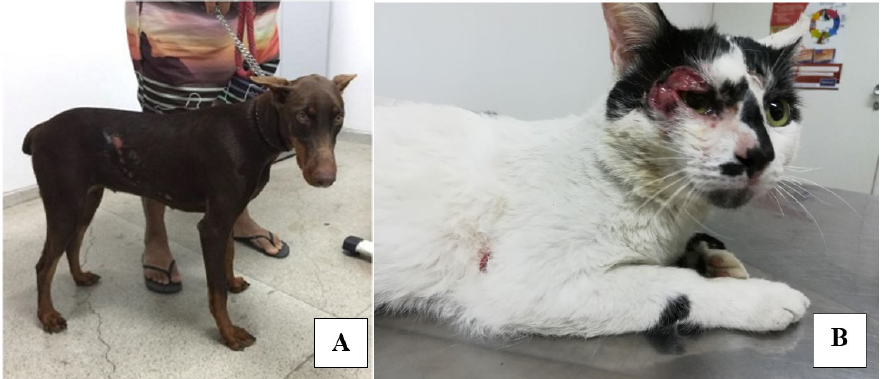
Figure 2. Canine with ulcerated lesions and feline with ocular lesion. Note 2A. Positive canine for sporotrichosis with ulcerated lesions. 2B. Positive feline for sporotrichosis with ulcerated ocular lesion /RJ. Source. Personal